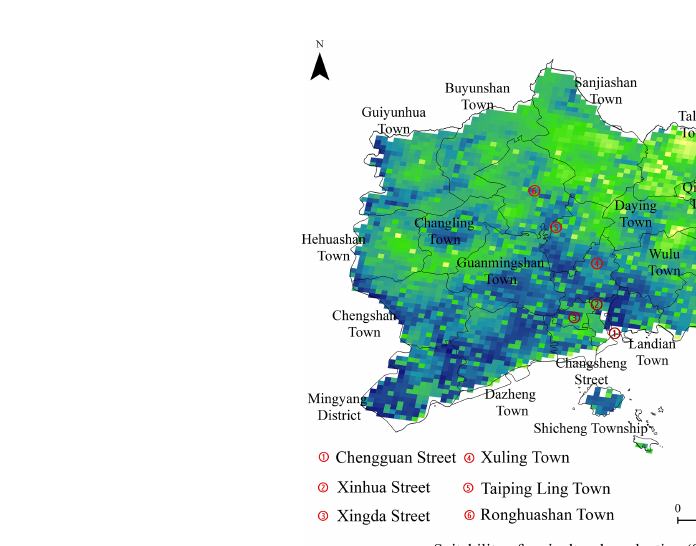
FIGURE 6 Evaluation of the suitability of agricultural